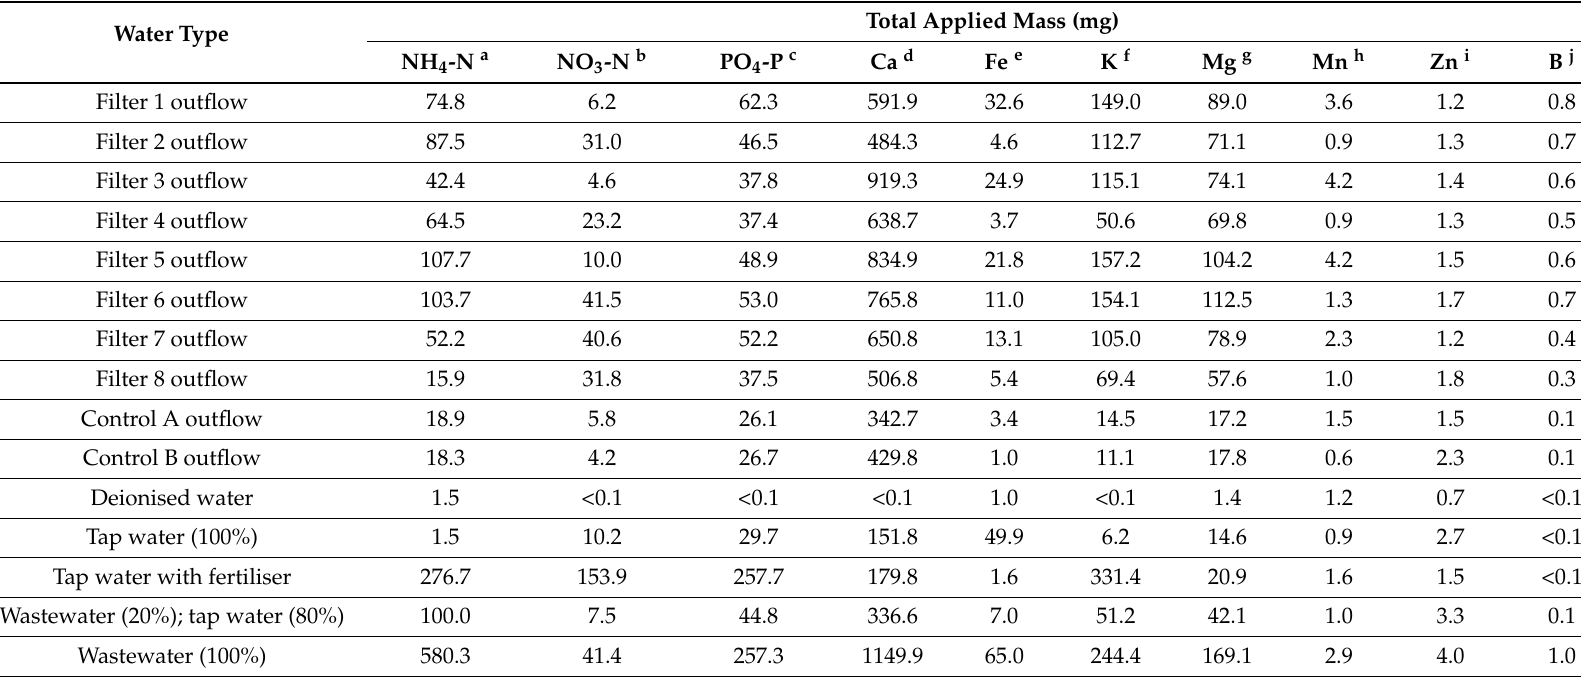
Table 6. Overview of element mass applied on plants grown in organic media subjected to different irrigation water types (11 October 2013 to 25 September 2014). Water